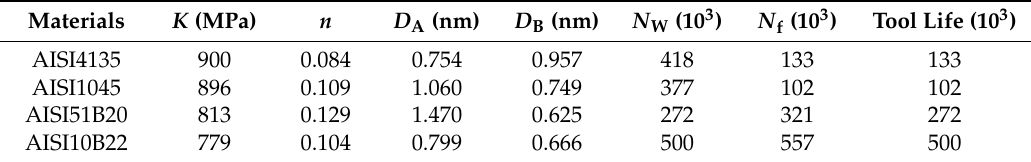
Table 1. Tool life calculated from integrated model for fatigue life, N f , wear life N W , using strength coefficient, K and strain hardening exponent n